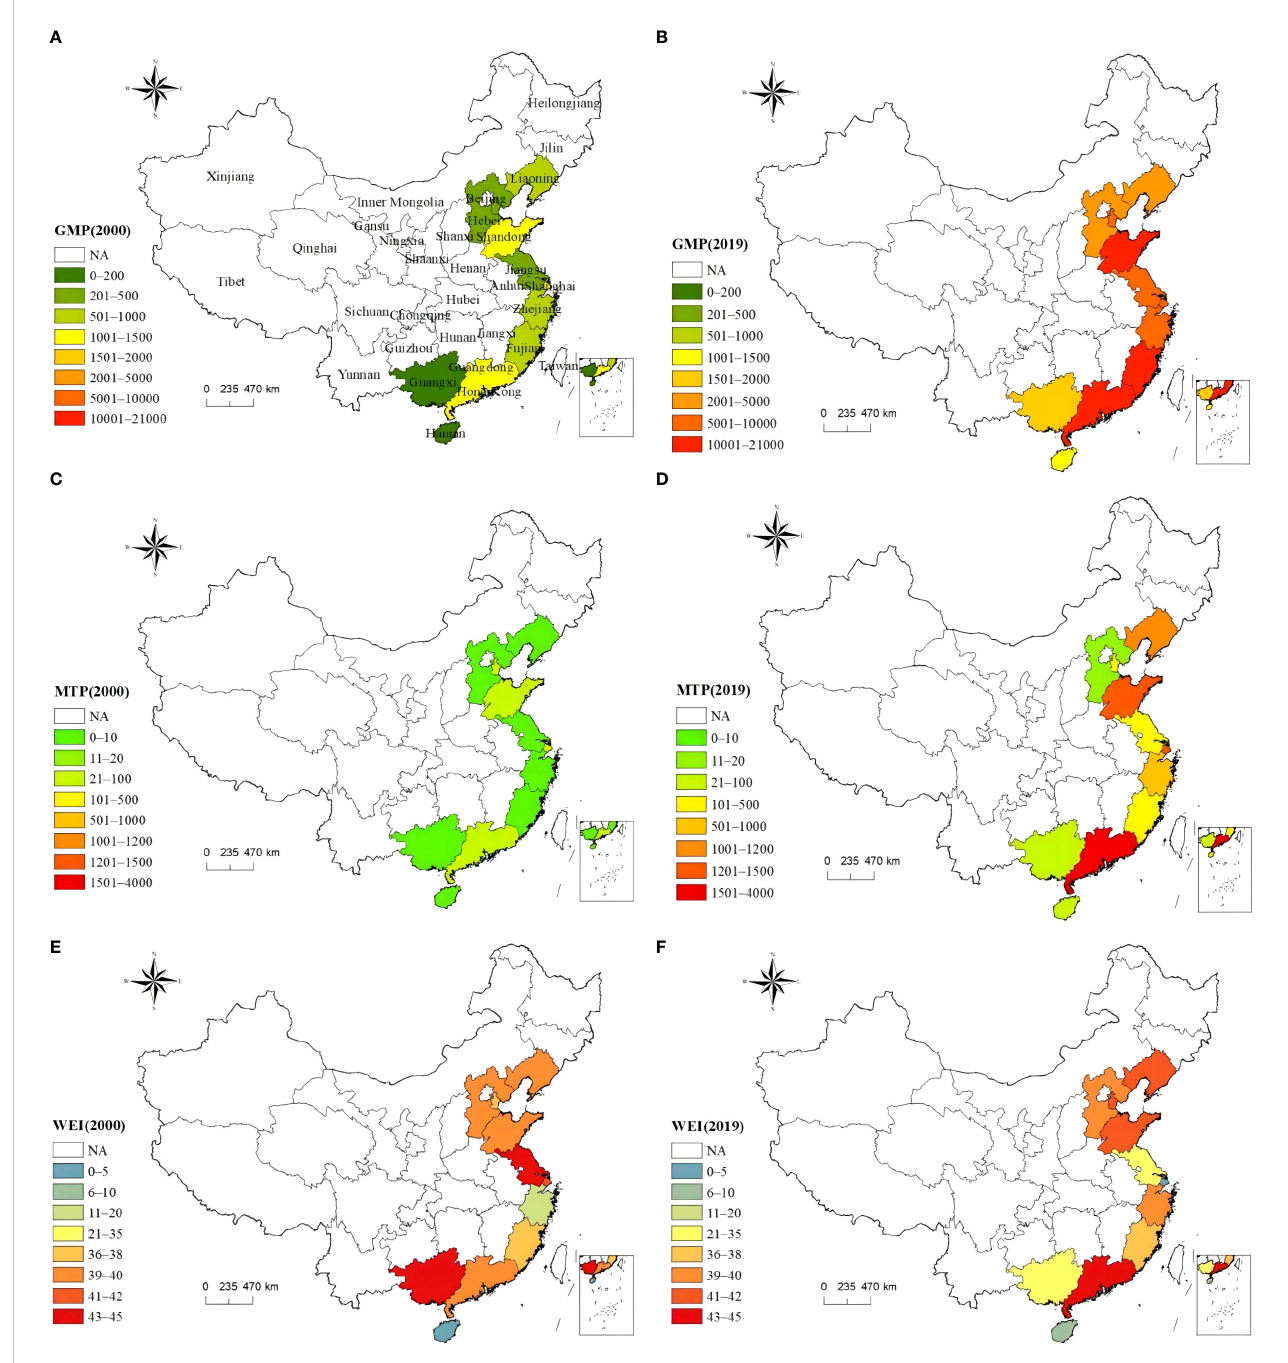
FIGURE 2 Temporal-spatial evolution characteristics. (A) GMP value of coastal areas in 2000. (B) GMP value of coastal areas in 2021. (C) MTP number of coastal areas in 2000. (D) MTP number of coastal areas in 2021. (E) WEI number of coastal areas in 2000. (F) WEI number of coastal areas in